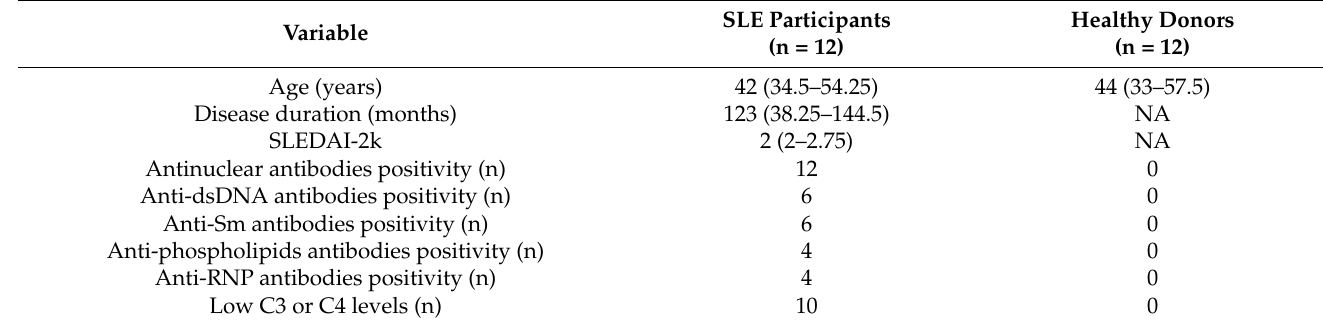
Table 1. Participants’ characteristics. SLEDAI: systemic lupus erythematosus disease activity